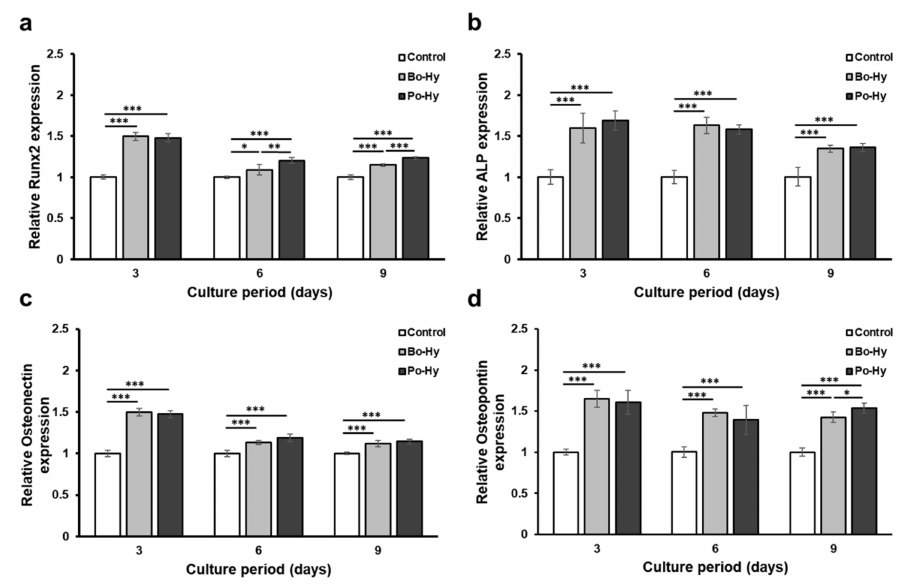
Figure 9. qPCR analysis of MC3T3-E1 cells on xenograft extracts. ( a ) Runt-related transcription factor 2 (Runx2), ( b ) ALP, ( c ) osteonectin (ON), ( d ) osteopontin (OPN) were selected as the osteogenic differentiation-related genes. Significant differences were observed when compared with the controls: * p < 0.05, ** p < 0.01, *** p < 0.001, n =